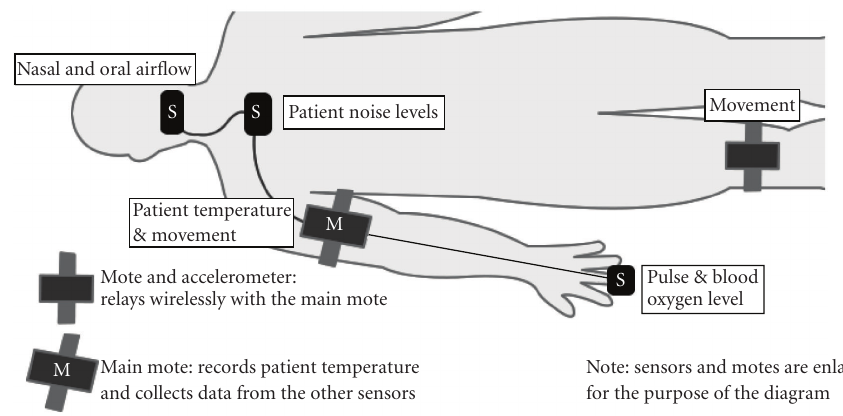
Figure 1: Diagram of the sensor network used for nighttime monitoring.